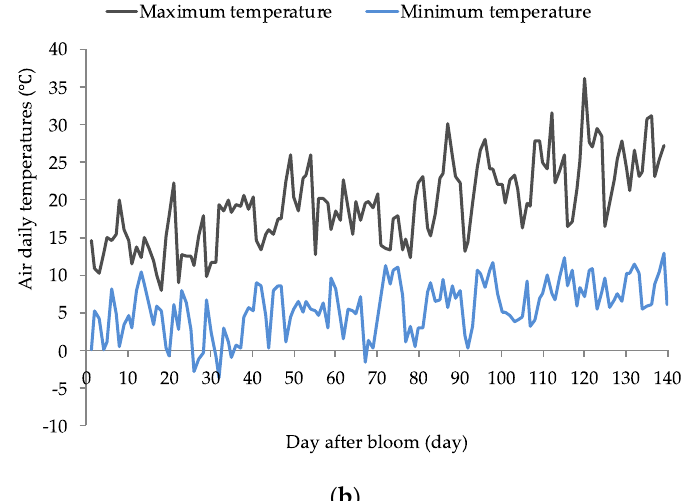
Figure 1. Environmental parameters for the San Ignacio location, Ñuble region, Chile: ( a ) accumulated precipitation (mm; orange line) and cumulative growing degree days (black line); ( b ) maximum and minimum temperatures.